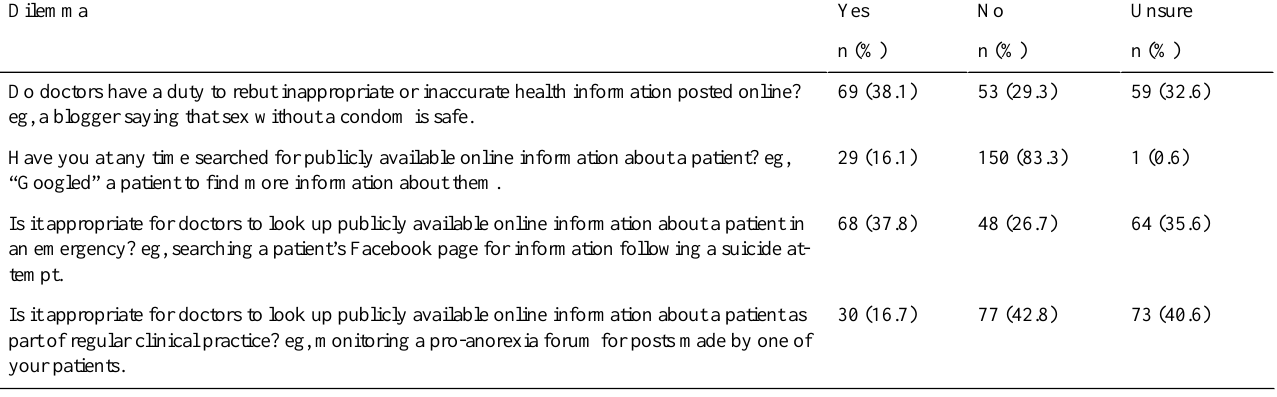
n (%)n (%)n (%) 59 (32.6)53 (29.3)69 (38.1)Do doctors have a duty to rebut inappropriate or inaccurate health information posted online? 1 (0.6)150 (83.3)29 (16.1)Have you at any time searched for publicly available online information about a patient? eg,